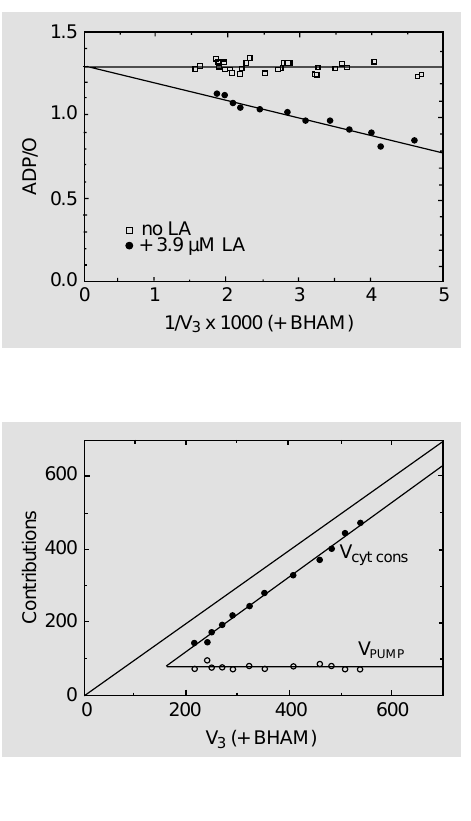
Figure 7 - Effect of AOX activity on the ADP/O ratio plotted ver- sus 1/V 3 . ADP/O and V 3 were measured with succinate plus rotenone as oxidizable substrate in the presence of 0.5% BSA and 1 mM GTP, and in the pres- ence or absence of 2 mM ben- zohydroxamic acid (BHAM). V 3 (expressed as nmol O min -1 mg protein -1 ) was decreased by in- creasing concentrations of n-bu- tyl malonate.